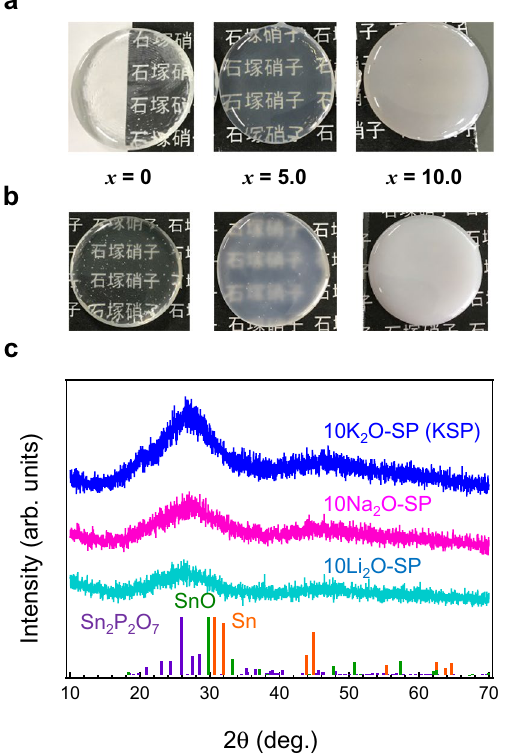
Figure 3. Transparency of alkaline-substituted KSP glasses. ( a ) Photographs of x Li 2 O − (10 − x )KSP and ( b) x Na 2 O-(10- x )KSP glasses melted at 500 °C for 10 min. The substitution fractions are 0, 5, and 10. ( c ) XRD patterns of KSP, 10Na 2 O-SP, and 10Na 2 O-SP glasses along with JCPDS patterns of Sn (#00-004-0673), SnO (#01- 072-1012), and Sn 2 P 2 O 7